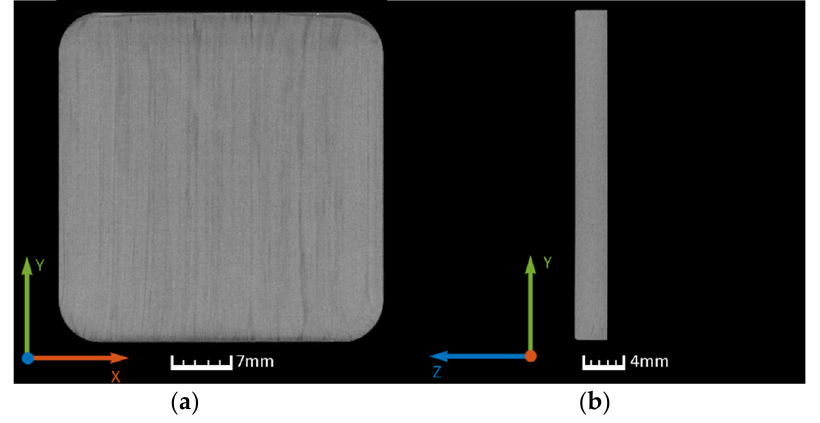
Figure 9. CT scan of the consolidated blockply specimen A: ( a ) xy-plane crossection; ( b ) yz-plane crossection.